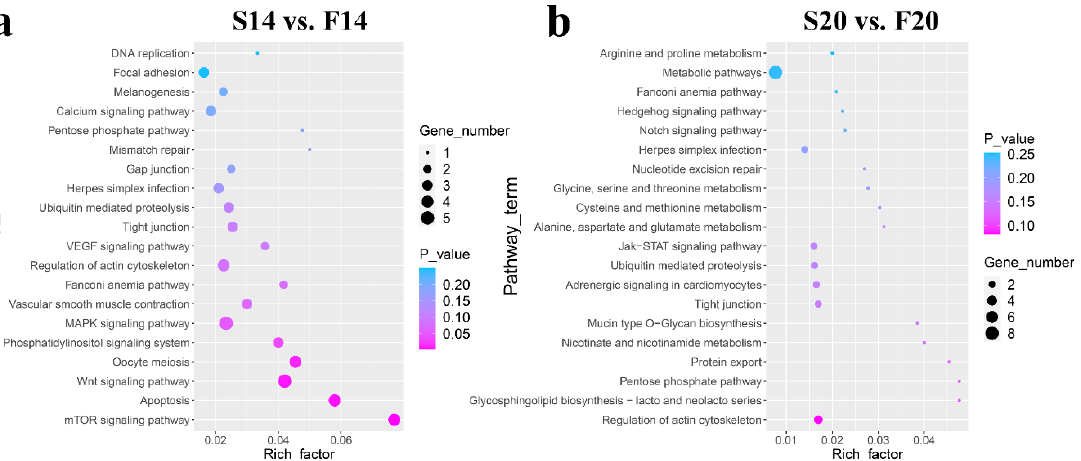
Figure 4. KEGG pathway analysis of the host genes of the differentially expressed circRNAs. ( a ) Results of KEGG analysis for S14 vs. F14. ( b ) Results of KEGG analysis for S20 vs.